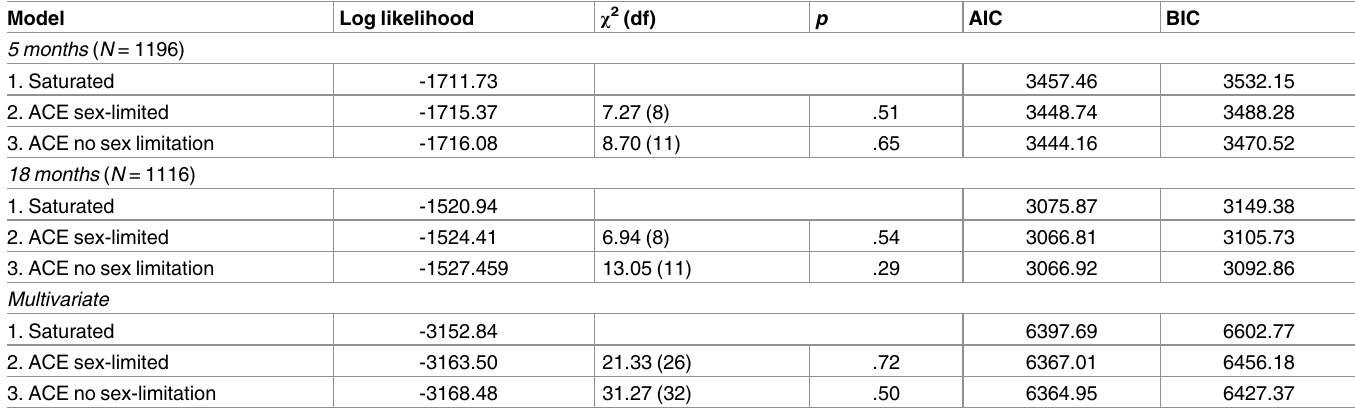
Table 3. Comparison of fit for univariate and multivariate models (with contrast effect).